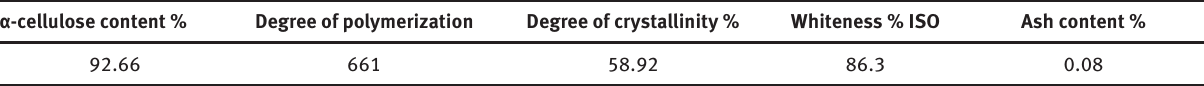
Table 1: Eucalyptus dissolved pulp quality